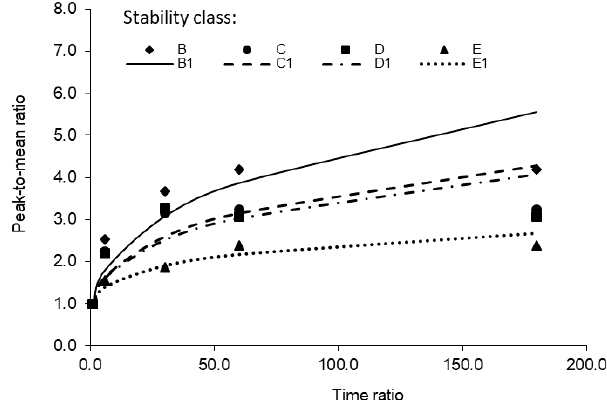
Figure 11. Variation of the PMR_OI with the time ratio (t m /t p ) at 1000 m from the odour source under different atmospheric stability classes (B1, C1, D1, and E1 are curves predicted by the equation PMR_OI = ( t / t q for stability classes B, C, D, and E, m p )